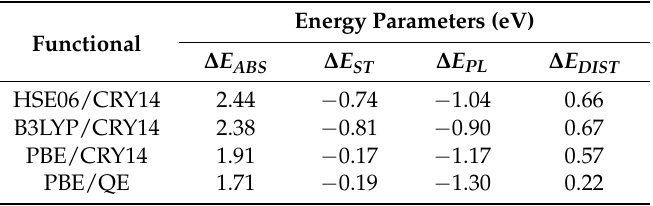
Table 3. Comparison of the energy parameters for the intermediates involved in the processes schematically described in Figure 8 as obtained with different functionals and a 6 × 6 supercell. The definition of the energy parameters is given in Section 2 of Computational